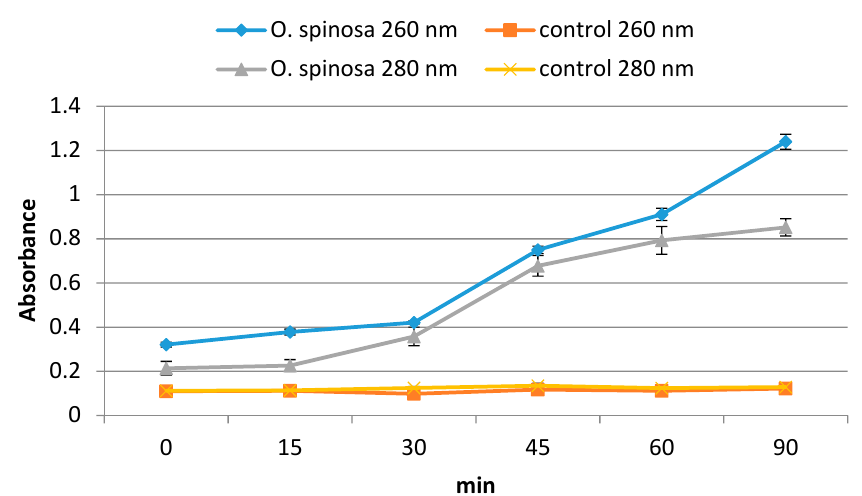
Figure 3. Leakage of cellular components recorded by absorbance at 260 and 280 nm in C. albicans treated with O. spinosa methanolic extract at 2 × MIC (minimum inhibitory concentration). There has been significant difference between control and treated samples ( p < 0.05).